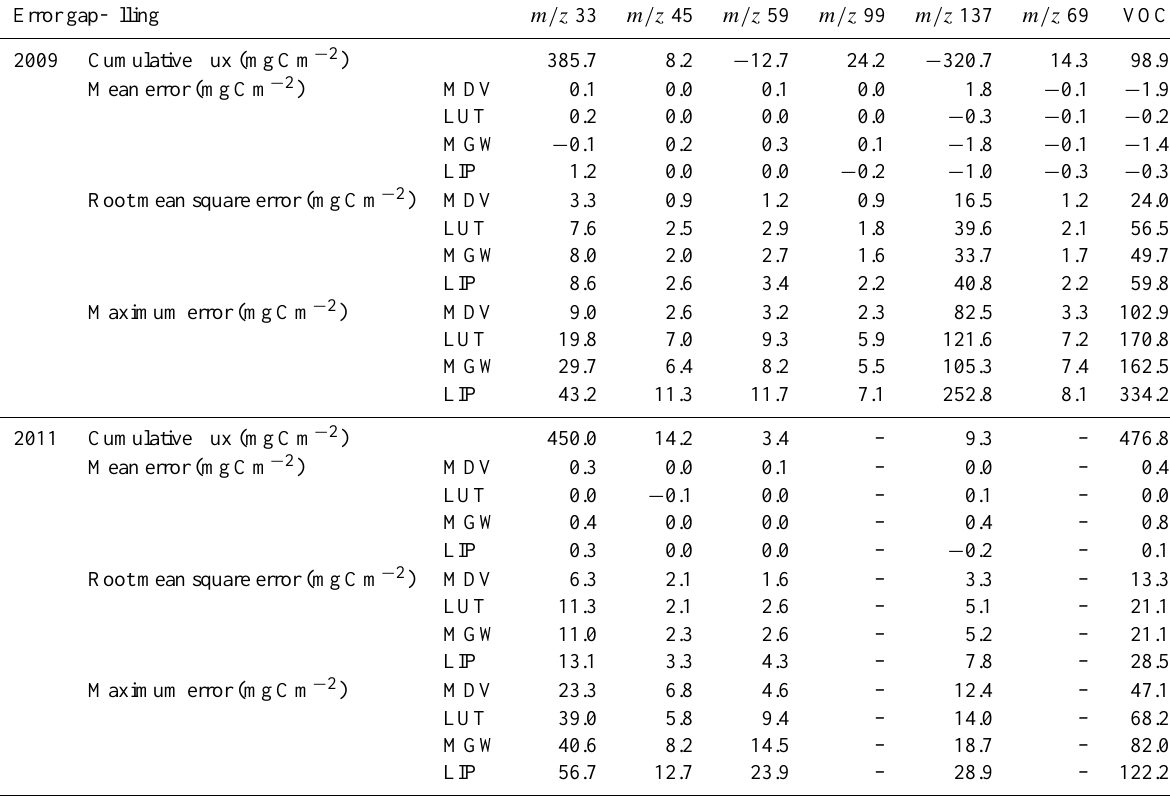
Table 1. Overall cumulative flux (averaged over all methods), mean error (systematic deviation in a positive or negative direction), root mean square error and maximal error (maximal deviation from reference) calculated for the four different gap-filling routines (mean diurnal variation, look-up tables, mean gliding window, linear interpolation) which were applied to the measured VOC data series for the years 2009 and 2011 (cutting times were previously excluded for the error simulation) Error